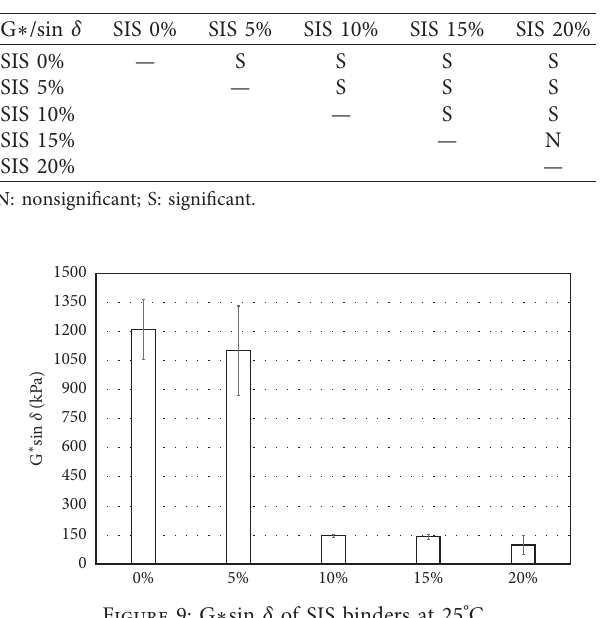
Table 3: Statistical analysis results of the G ∗ /sin δ value as a function of SIS content.